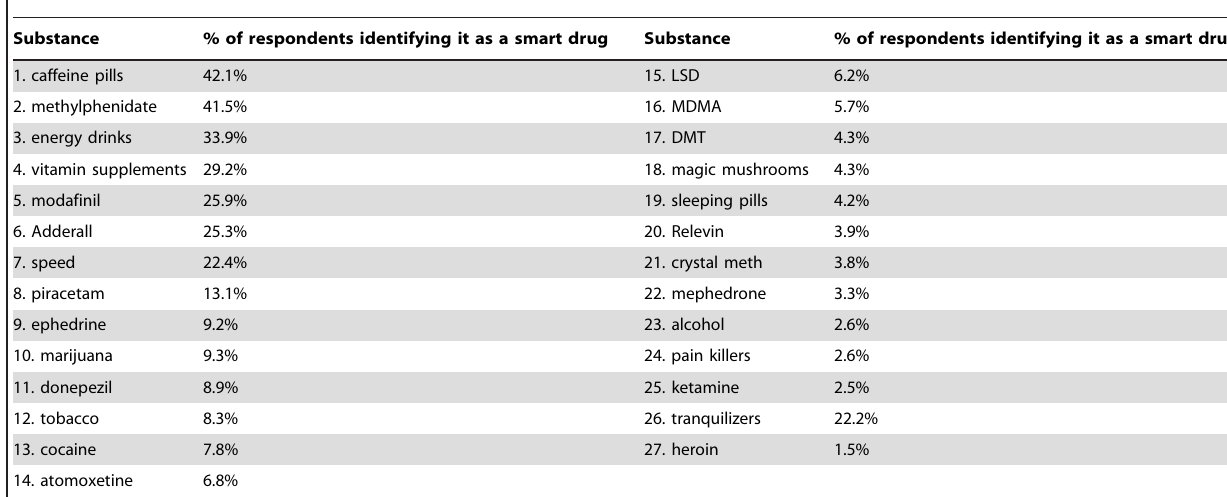
Table 2. What is a smart drug? ( n =877).